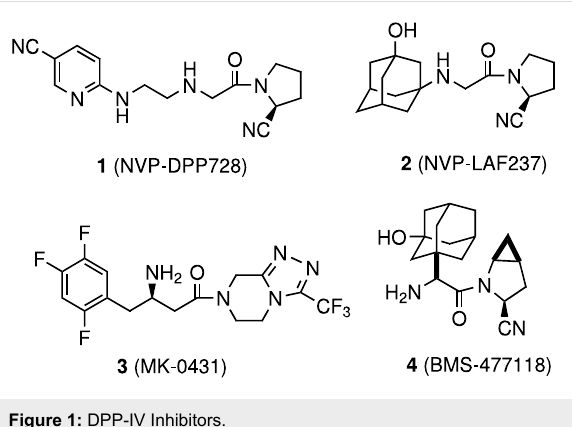
the N -terminus [14,15]. Thus inhibition of DPP-IV extends the half-life of endogenously secreted GLP-1, which in turn enhances insulin secretion and improves the glucose tolerance.